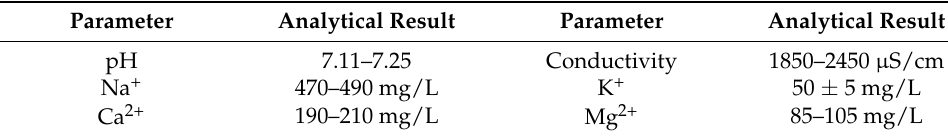
Table 1. Quality of synthetic wastewater used in this study.